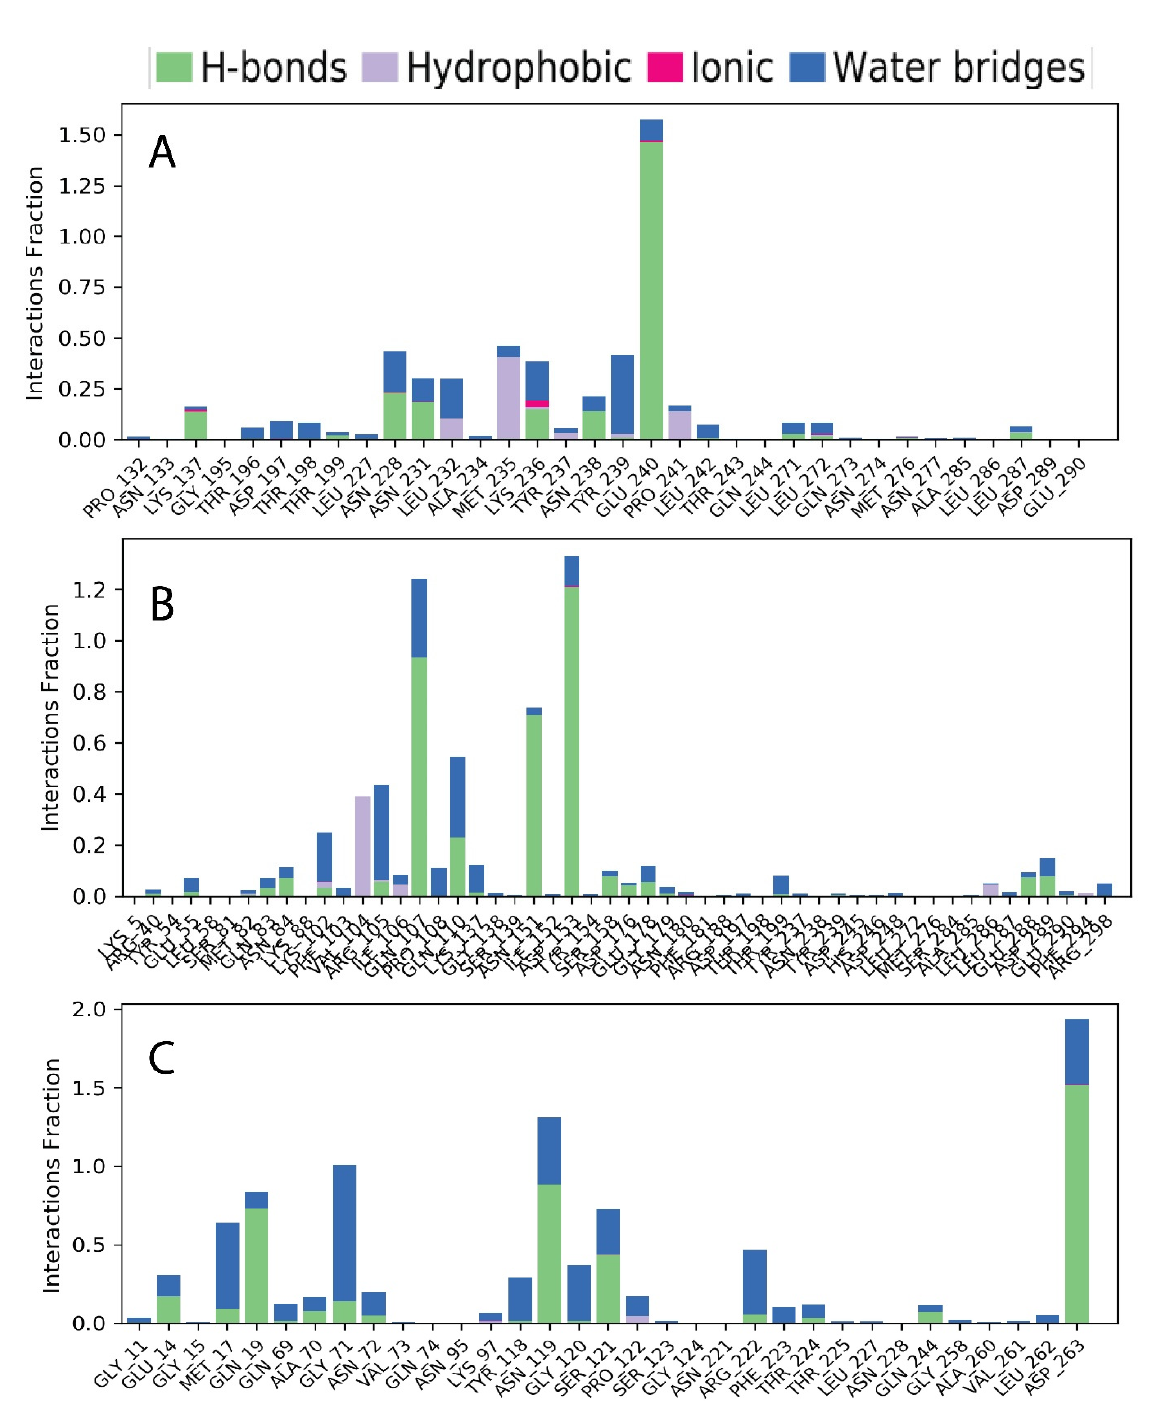
Figure 13. The stacked bar charts illustrate the interactions between proteins and ligands discovered during the 100 ns simulation. The interaction of the three ligand compounds ( A ) 4,5-di-O- Caffeoylquinic acid (CID-6474309), ( B ) rutin (CID-5280805), and ( C ) schaftoside (CID-442658) in association with the selected protein is illustrated in this section.